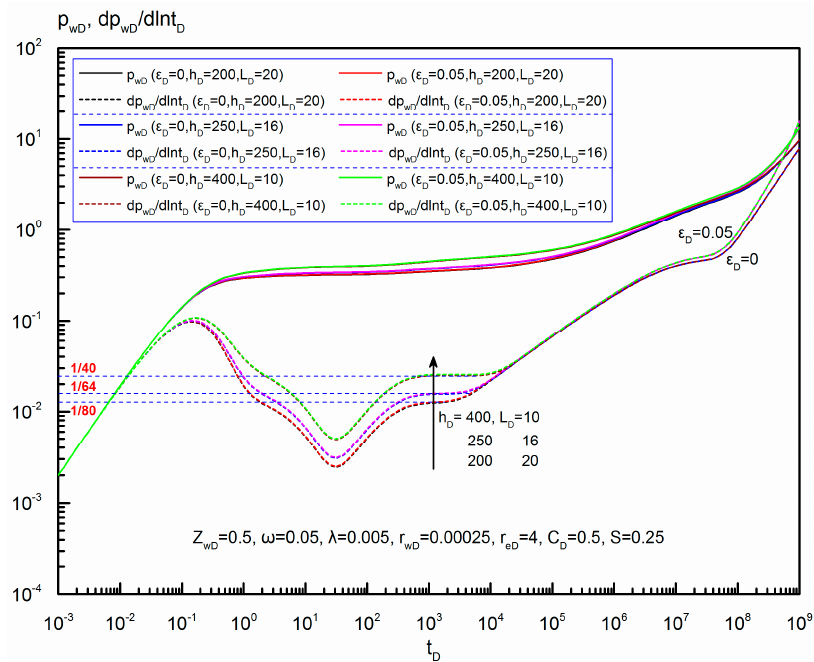
Figure 10. Effect of dimensionless reservoir thickness ( h D ) on horizontal well’s transient pressure behavior.